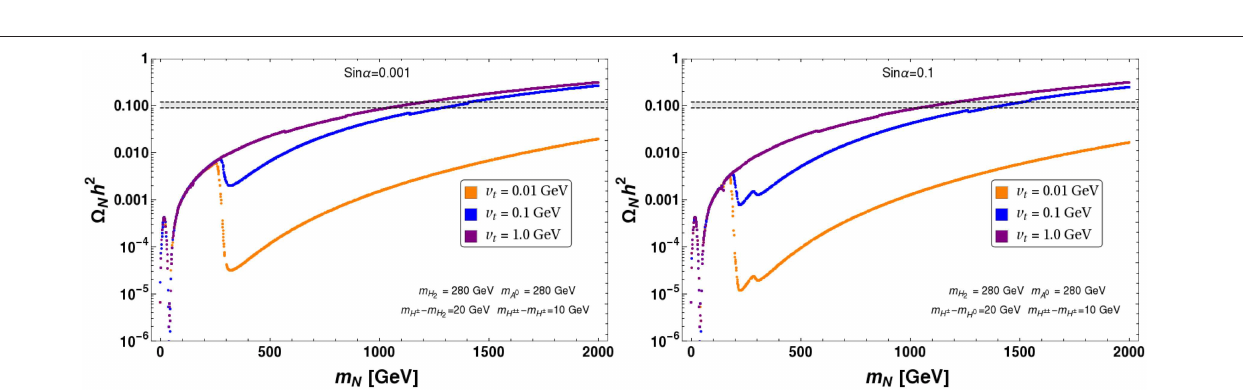
FIGURE 11 | Relic density vs. m N plot for different choices triplet vev, v t , keeping sin α the figure. The gray patch indicates relic density bounds. In both cases we set f N